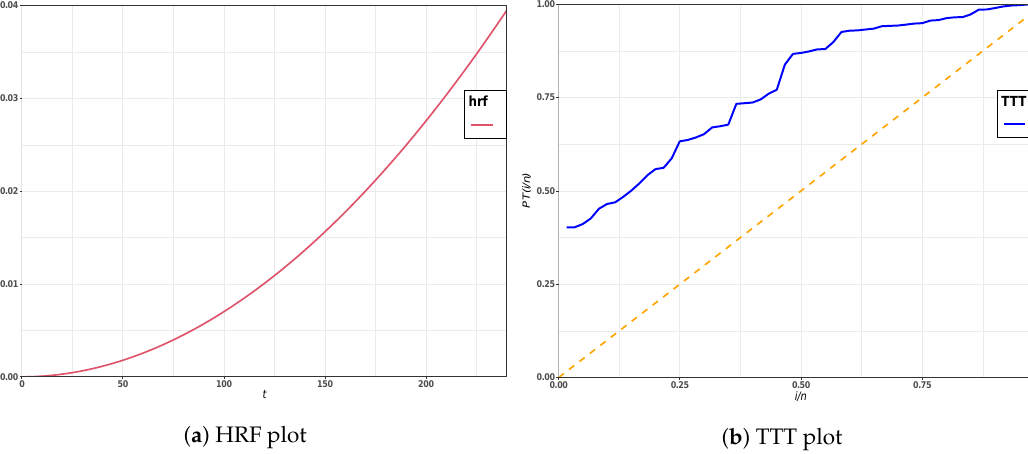
Figure 6. The HRF plot of the GRL distribution and TTT plot for epicenter